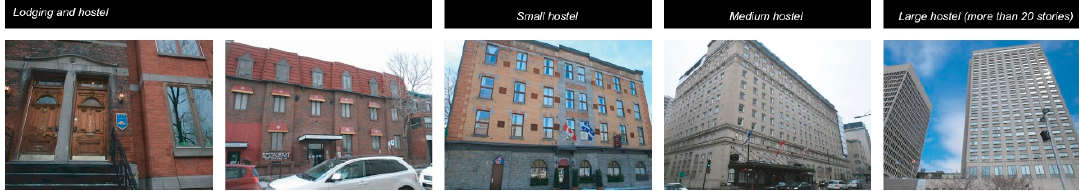
Figure 3. Tourist accommodations grouped in four types: ( 1 ) Bed and Breakfast; ( 2 ); small hotel ( 3 ), intermediate hotel; ( 4 ) large hotel.